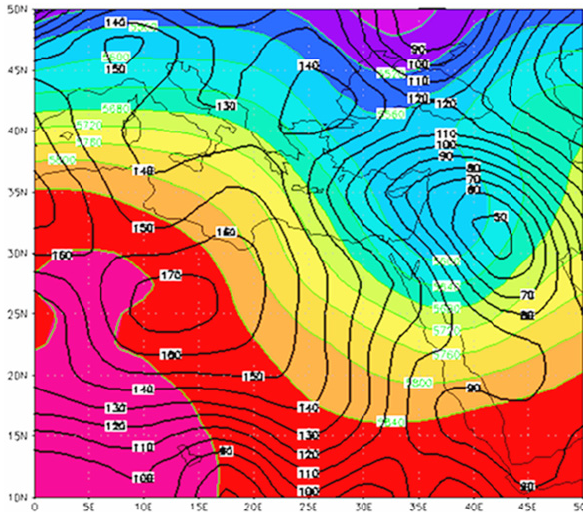
Fig. 2. Geopotential height (gph) at 1000hPa (contours) and 500hPa (shading) for 2 April 2006,